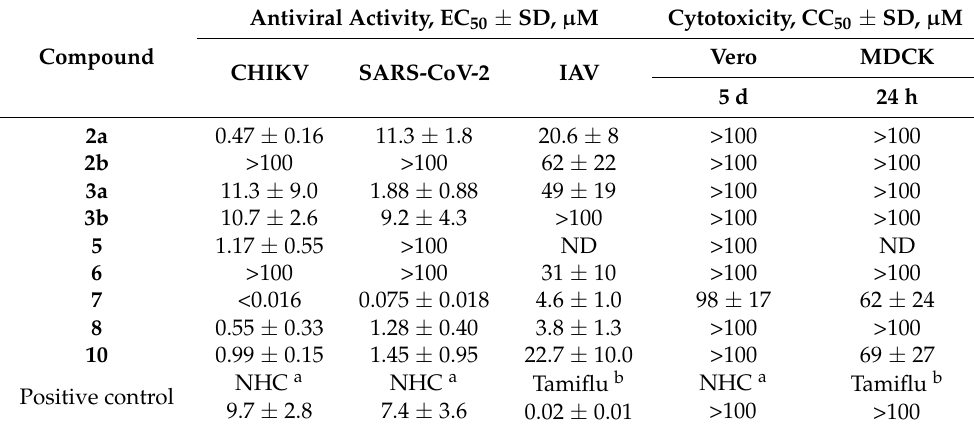
Table 1. In vitro antiviral activity and cytotoxicity of perylene-based compounds against CHIKV, SARS-CoV-2, and IAV (M ± SD).